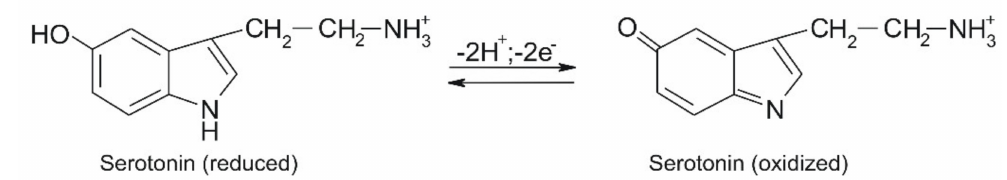
Figure 2. Electrochemical oxidation of serotonin (adapted from [63]). Serotonin (oxidized)—Serotonin